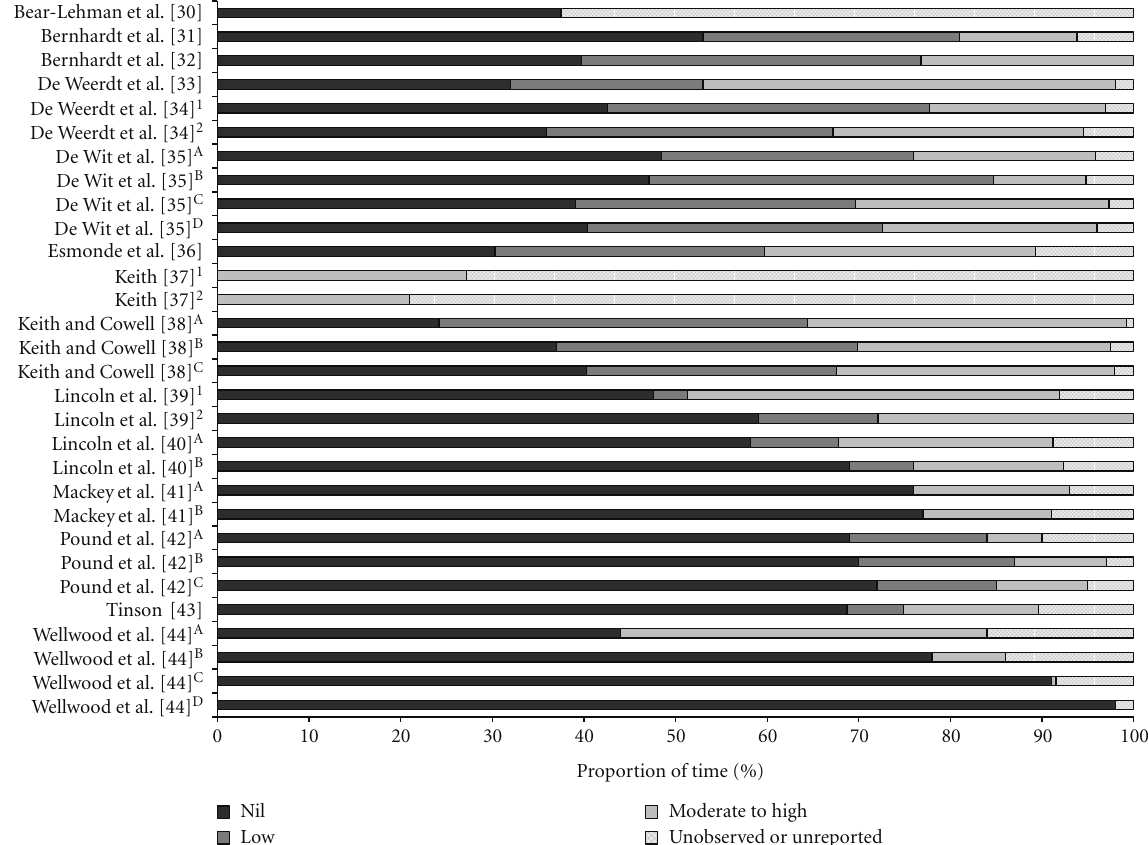
Figure 1: Physical activity across the day. 1 and 2 denote di ff erent time periods of observation; A, B, C, and D denote di ff erent hospital